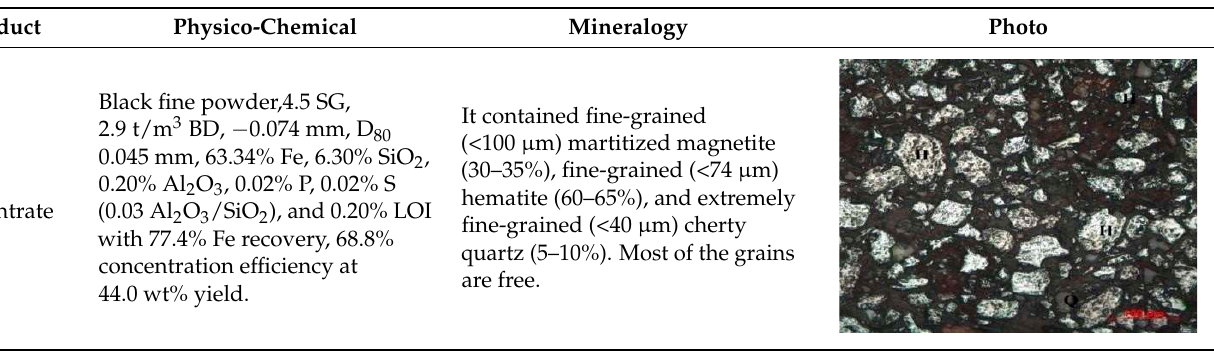
Table 12. The characteristics of tails of the final